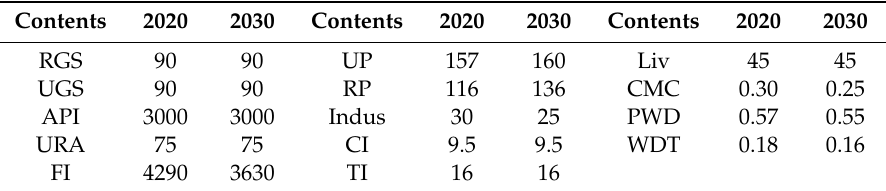
Table 2. Water quota forecast in 2020 and 2030. Rural green space (RGS, L / m 2 ), urban green space (UGS, L / m 2 ), artificial plantation irrigation (API, m 3 / ha), urban roads area (URA, L / m 2 ), farmland irrigation (FI, m 3 / ha), urban population (UP, L / person · day), rural population (RP, L / person · day), industry (Indus, m 3 / 10 4 yuan added value), construction industry (CI, m 3 / 10 4 yuan added value), tertiary industry (TI, m 3 / 10 4 yuan added value), livestock (Liv, L / day), coal mine comprehensive (CMC, m 3 / t), petrochemical water demand (PWD, m 3 / t), and water demand of thermal power and coal gangue power plant (WDT, m 3 / s · GW) were selected as the basis for predicting water demand.